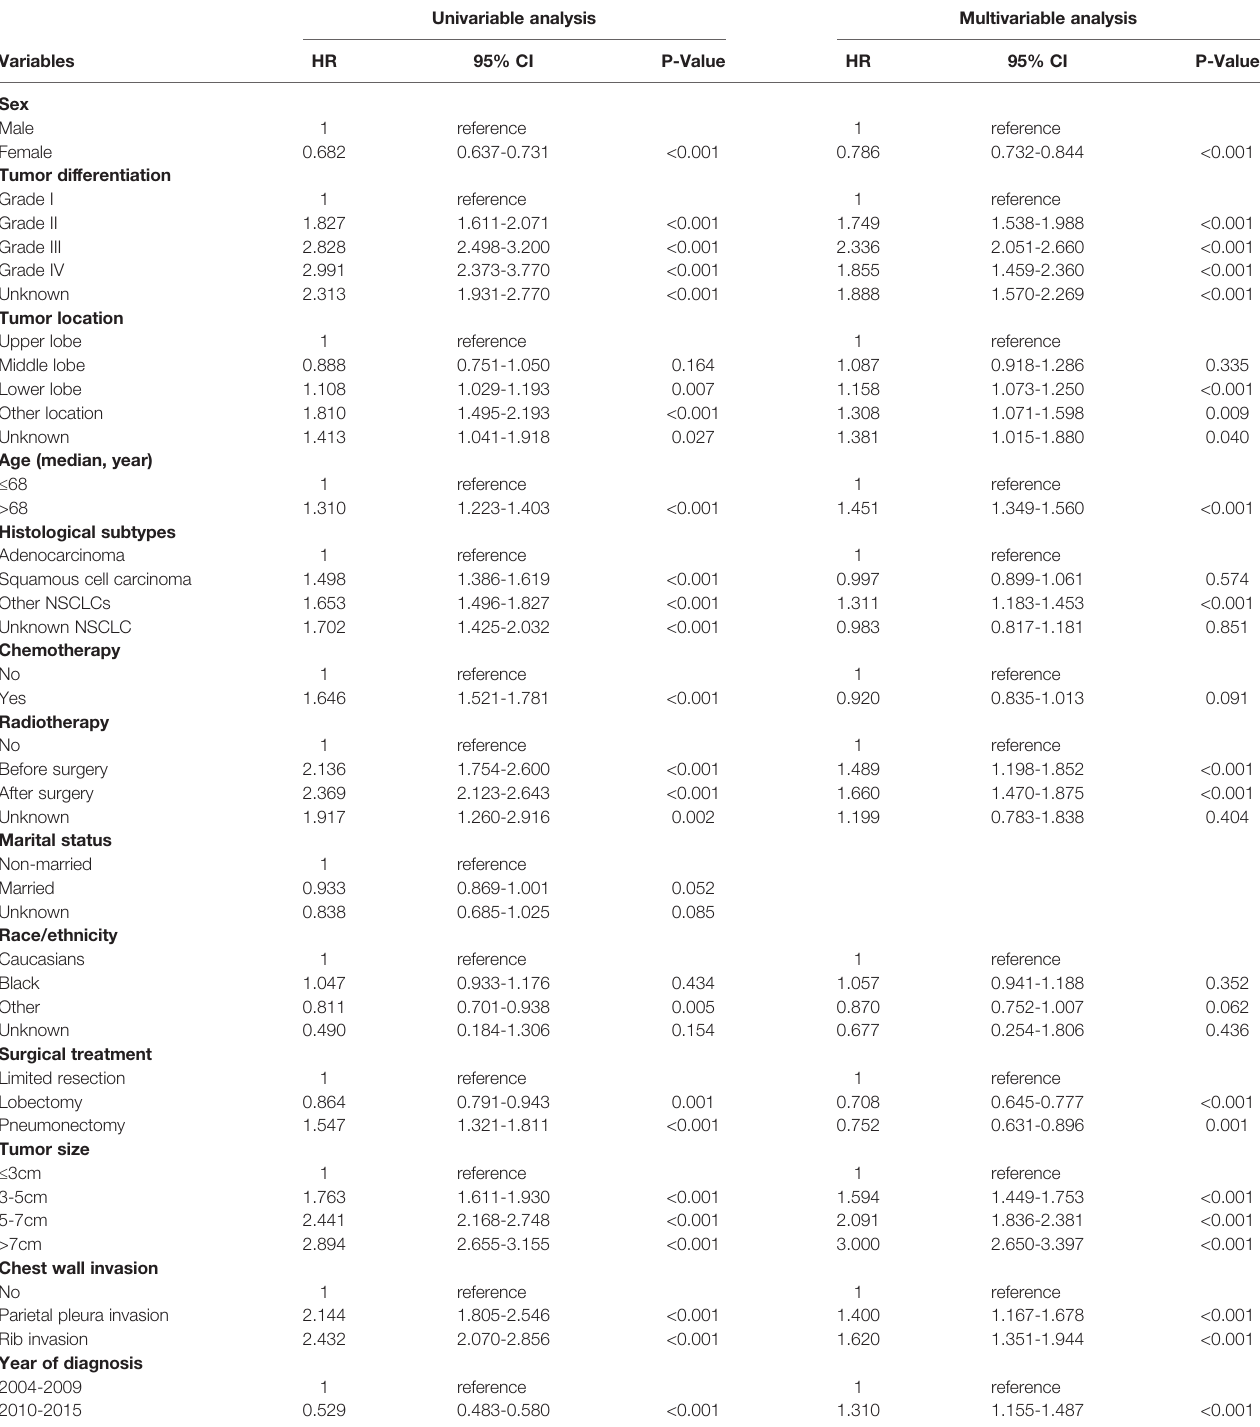
TABLE 2 | Univariable and multivariable Cox regression analysis for cancer-speci fi c mortality in patients with different statuses of parietal pleura invasion and rib